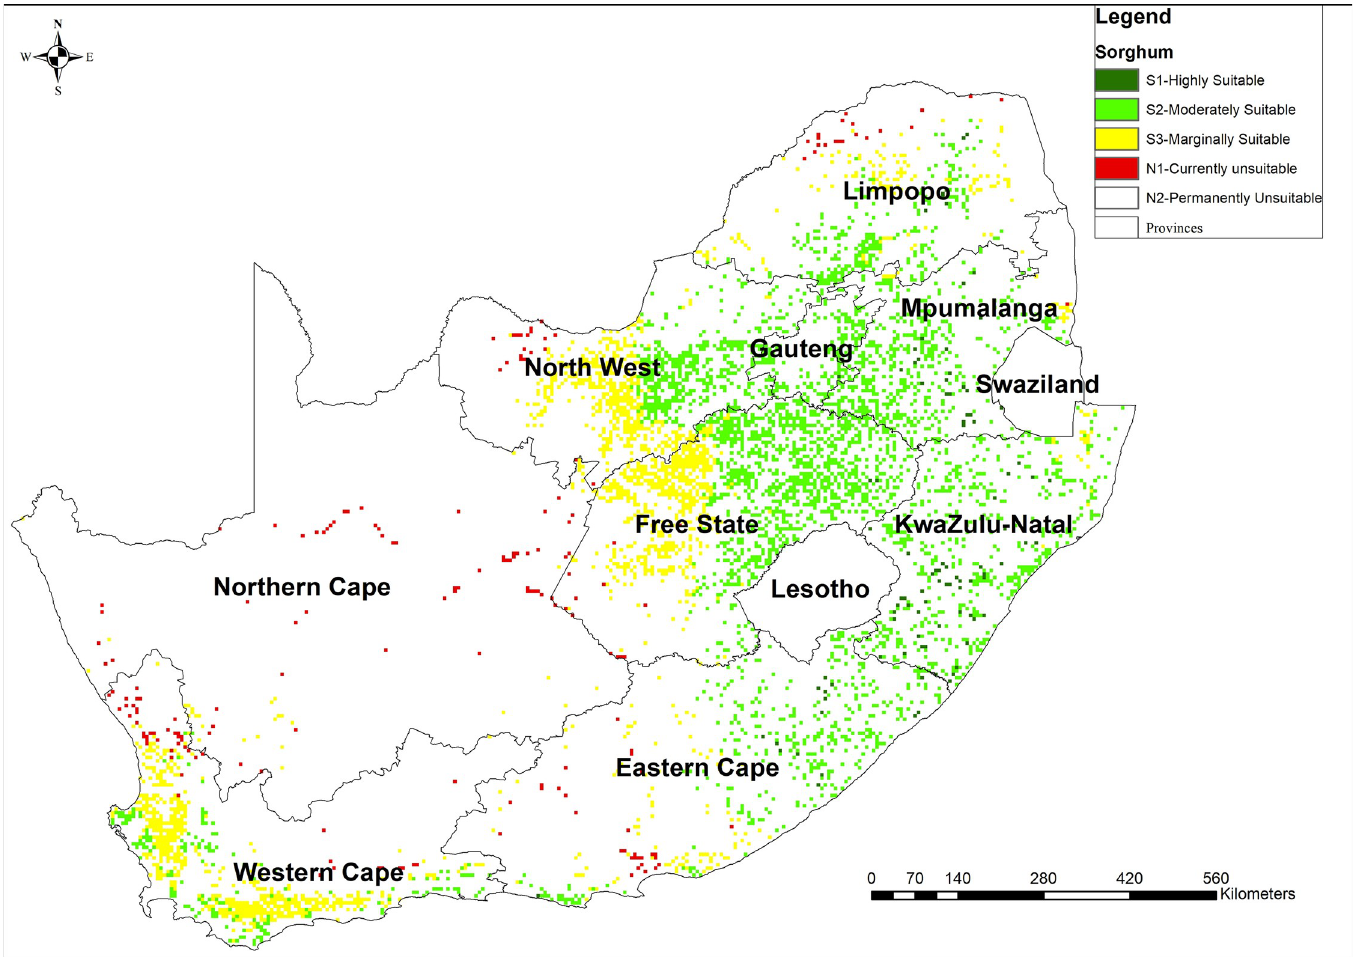
Fig 2. Suitability map for sorghum production in South Africa computed using MCDA-AHP and OWA operators [Source, South African Quaternary Catchments database , ( https://doi.org/10.6084/m9.figshare.13179881 ) , in ArcGIS 10 . 5] .